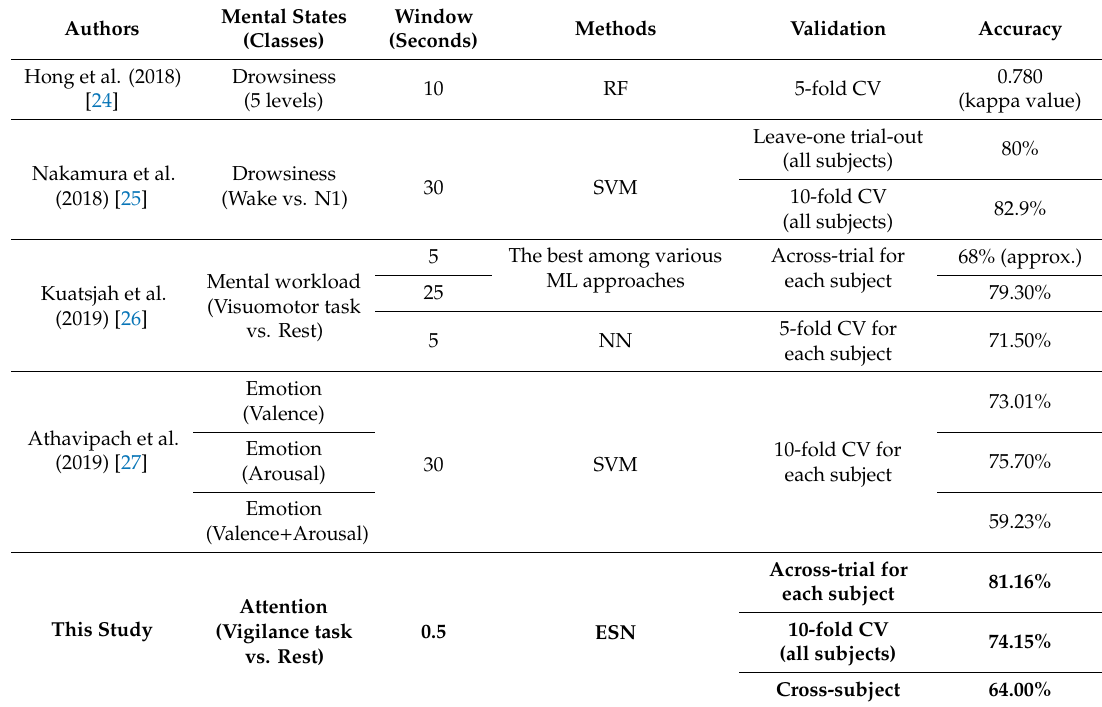
Table 5. Comparison with previous studies on asynchronous brain–computer interface (BCI) using in-ear EEG signals (CV denotes